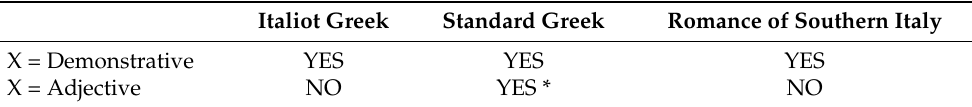
Table 2. X Num N .